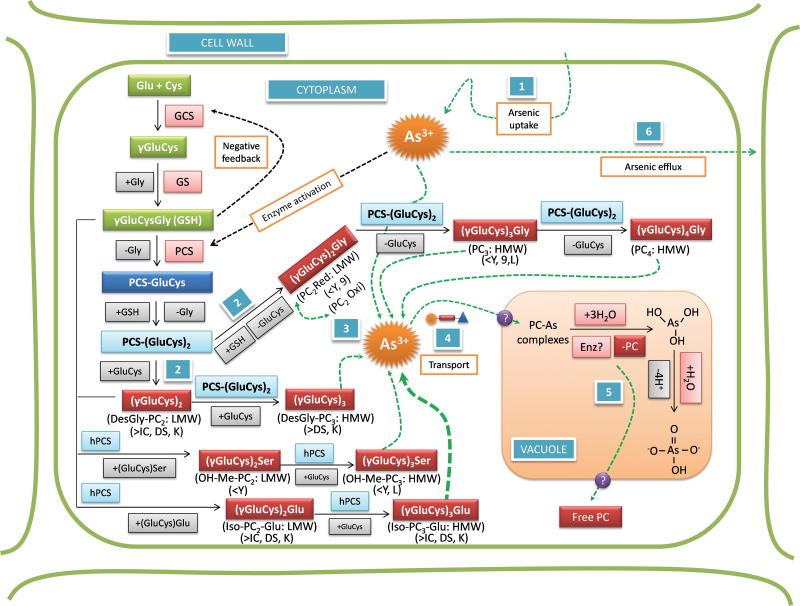
Probable pathways of phytochelatins (PCs) biosynthesis in roots of rice: data from literature, correlation between the PCs found here and the PCs related to the cultivars studied. Cultivars: L, Lemont; DS, Dom Sofid; IC, Italica Carolina; Y, YRL-1; 9, 9524; K, Kitrana 508. LMW, low molecular weight; HMW, high molecular weight; PCS, PC synthase; GCS, γ-glutamylcysteine synthetase; GS, glutathione synthetase; hPCS, homo-PC synthases; 1, As uptake by roots; 2, production of LMW PCs; 3, As–PCs complexes (AsIII+2PC2, AsIII+PC3, for example) stored in the vacuole; 4, transport to vacuoles; 5, release of PCs; 6, efflux of As up-taken; ?, unknown information; >, high concentration; <, low concentration; thicker dotted line, PC highly effective. Scheme elaborated according to descriptions from Klapheck et al. (1994); Cobbett (2000); Chassaigne et al. (2001); Cobbett and Goldsbrough (2002); Oven et al. (2002); Meharg and Hartley-Whitacker (2002); Rey et al. (2004); Vatamaniuk et al. (2004); Song et al. (2010); and Wood and Feldmann (2012).